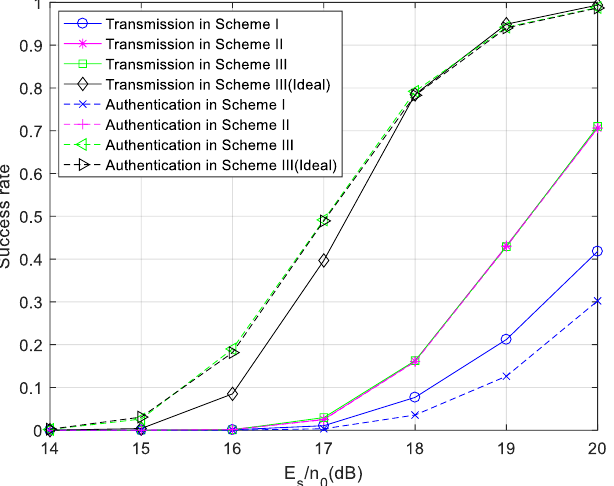
Figure 15. Success rates of user-data transmission and watermark authentication with a frequency offset in the Gaussian channel.